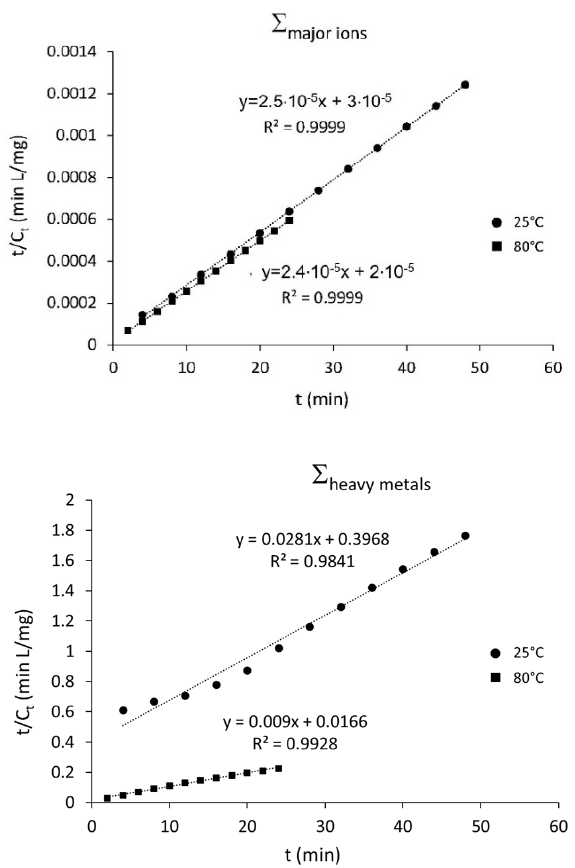
∑ heavy metals ( bottom ) and